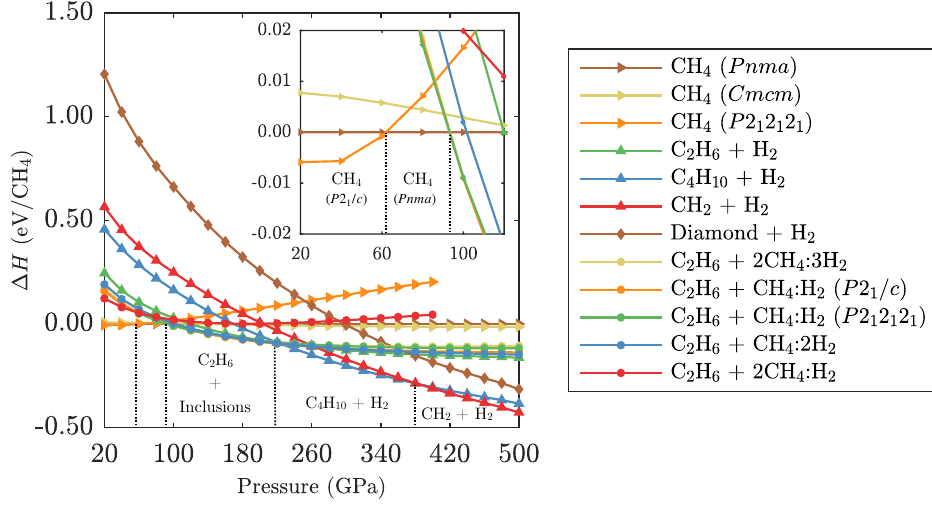
Figure 3. Ground state PBE enthalpies of relevant CH 4 phases and phase mixtures relative to CH 4 - Cmcm . Enthalpies are normalised per unit of CH 4 . For example, “Diamond + H 2 ” refers to ∆ H = H ( C-dia ) + 2 H ( H ) − H ( CH ) . Inset shows the low pressure region in more 2 4 - Cmcm